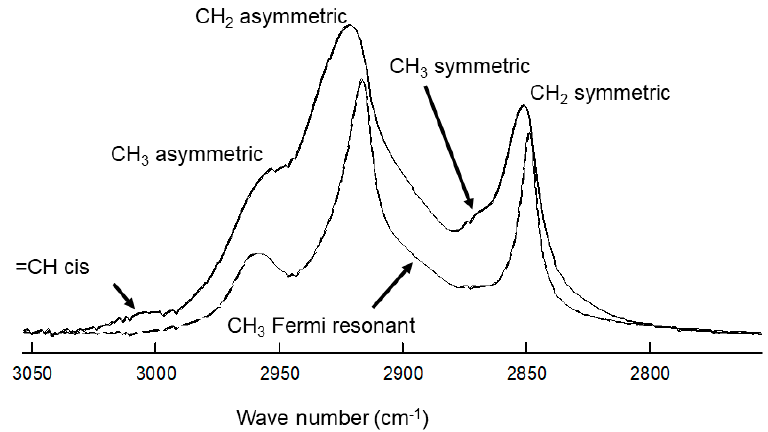
Figure 2. Infrared CH stretching region spectrum of tear lipids from (top) a 63-year-old Caucasian male with no dry eye. (bottom, ---) Infrared spectrum of tear lipids that were catalytically saturated. Note that there are no cis hydrocarbon chain double bonds in the saturated sample spectra.